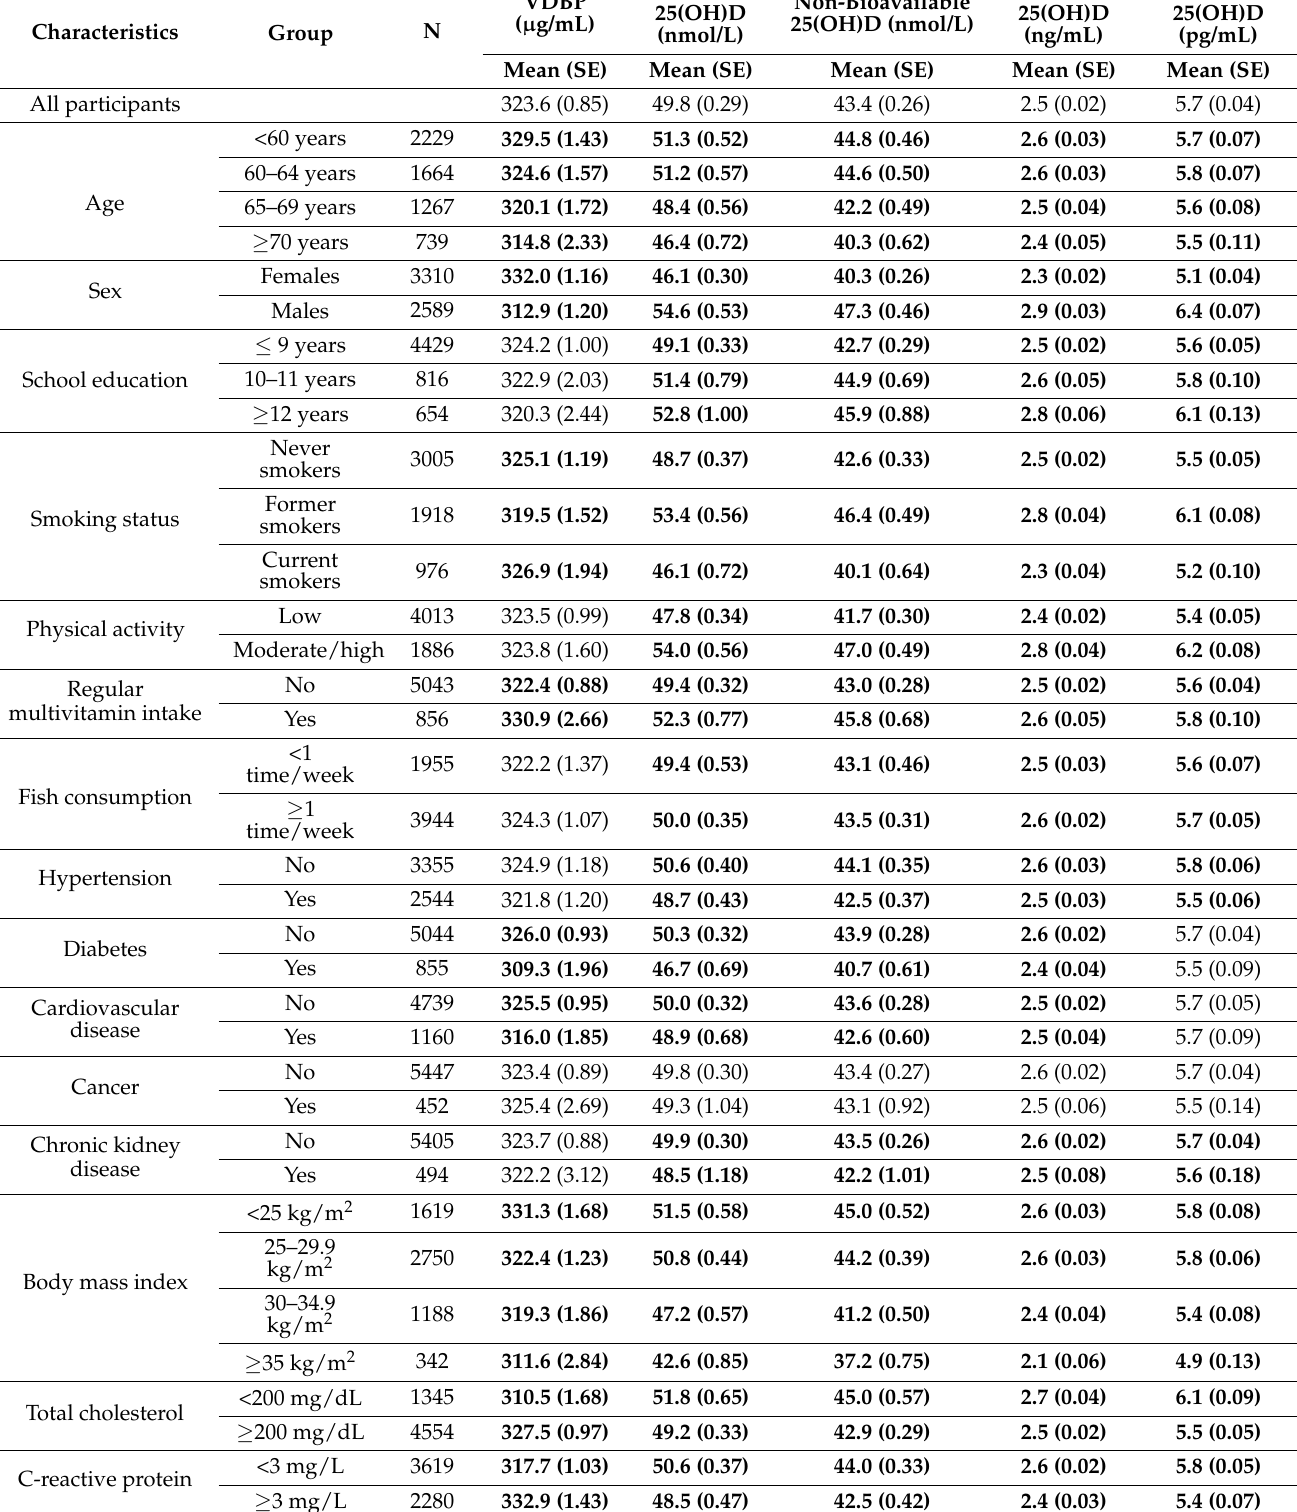
Table 2. VDBP, total, non-bioavailable, bioavailable, and free 25(OH)D concentrations by selected